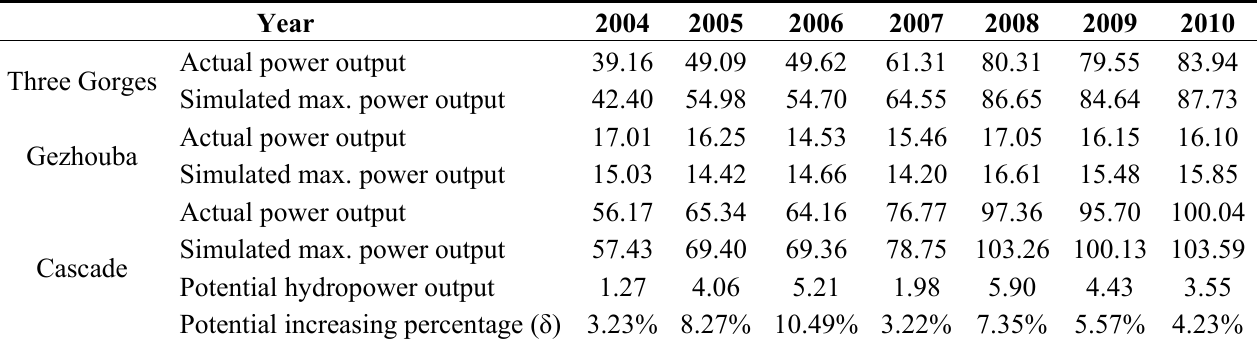
Table 2. Results of integrated evaluation of power generation benefit for joint operation of The Three Gorges and Gezhouba Cascade Complex